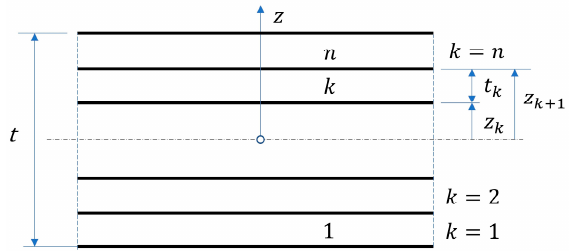
Figure 4. Laminate material of thickness 𝑡 with 𝑛 orthotropic homogeneous layers .